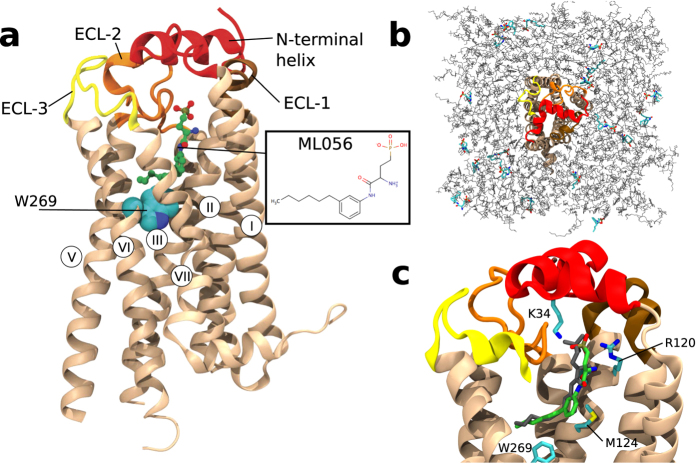
The structure of S1P1R and the simulation setup.(a) Crystal structure of S1P1R (PDB id: 3V2Y). (b) Top-down perspective of starting structures for MD simulations. S1P1R shown in cartoon representation in red. Top and bottom lipid layer shown in gray. ML056 ligands shown as thick sticks colored in cyan, blue, red and gold. Water, ions, and hydrogens are not shown for clarity. (c) Closest bound pose of the ML056 ligand from these simulations (green) relative to the crystal structure (gray), along with several key residues (cyan). The pose pictured has an RMSD of <1 Å relative to the crystal-bound pose.